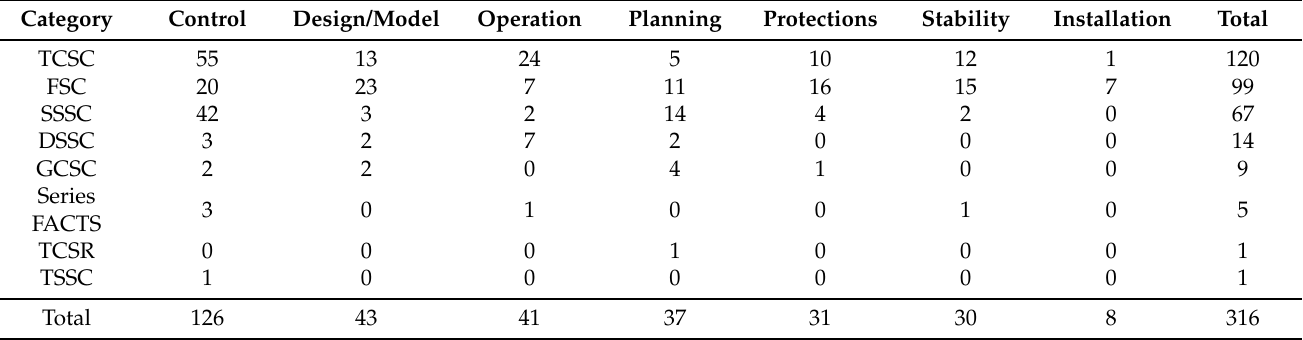
Table 2. Taxonomy of journals by their main